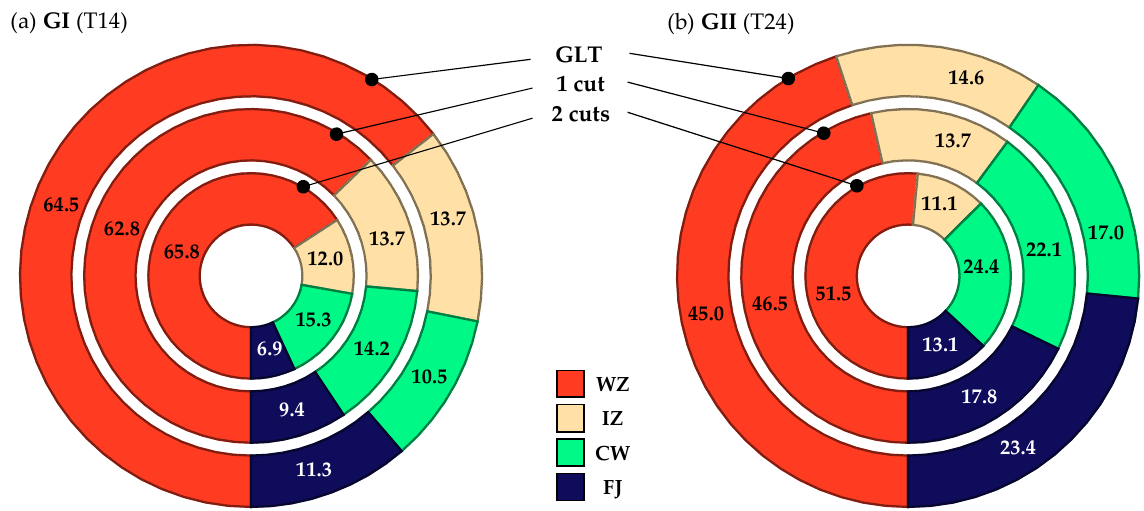
Figure 23. Mean values of the relative shares of the causes of failures ( F max ), classified according to the types of board segments in {CW—Clear wood; IZ—Intermediate knot zone; WZ—Weak zone; FJ—finger joint}, for glulam and resawn glulam beams built up of virtually generated boards of GI ( a ) and GII ( b ).